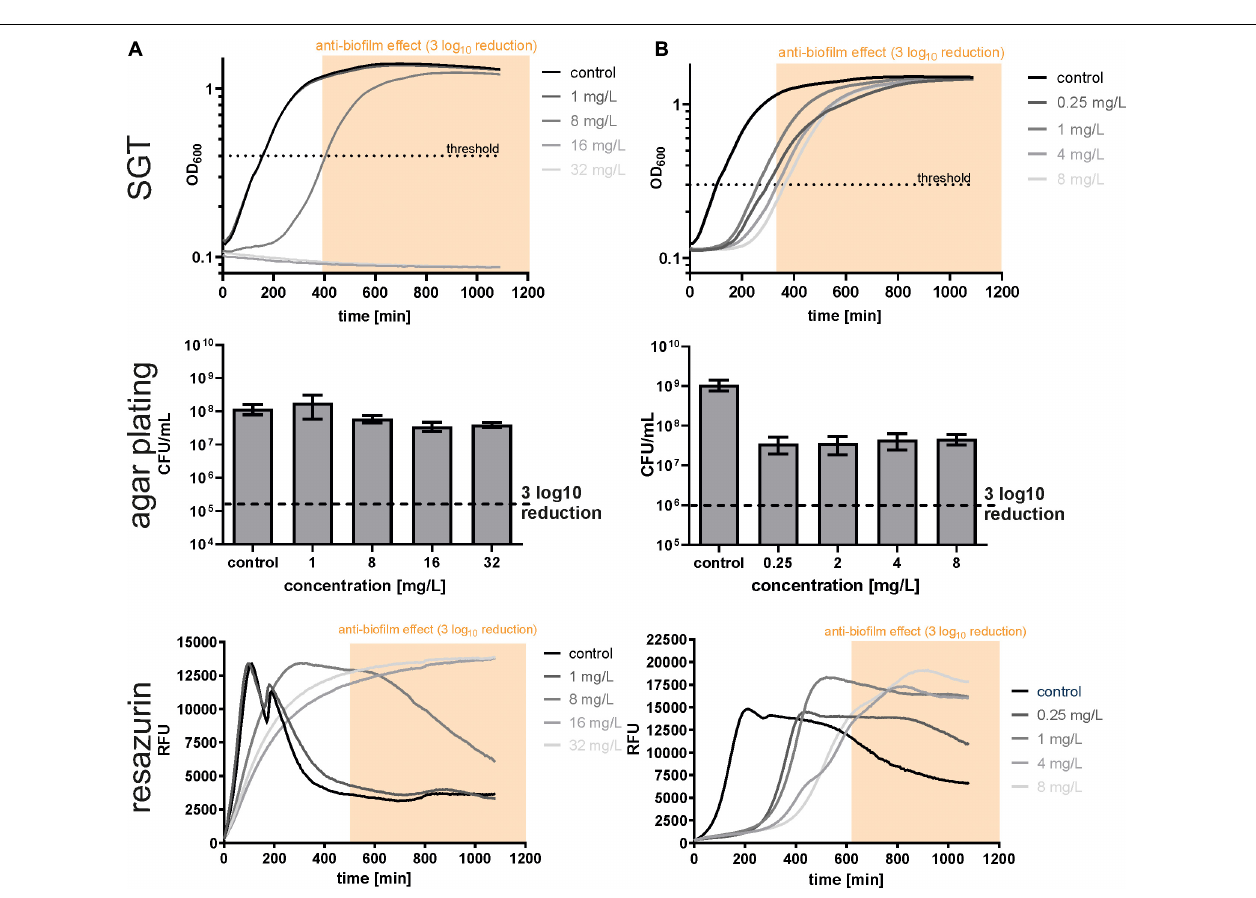
FIGURE 3 | Determination of biofilm bactericidal effects with the three different methods in SA4002 biofilms treated with dalbavancin (A) and rifampicin (B) . The yellow window (“anti-biofilm effect”) indicates the area with an at least 3 log 10 reduction in CFU compared to the untreated control.